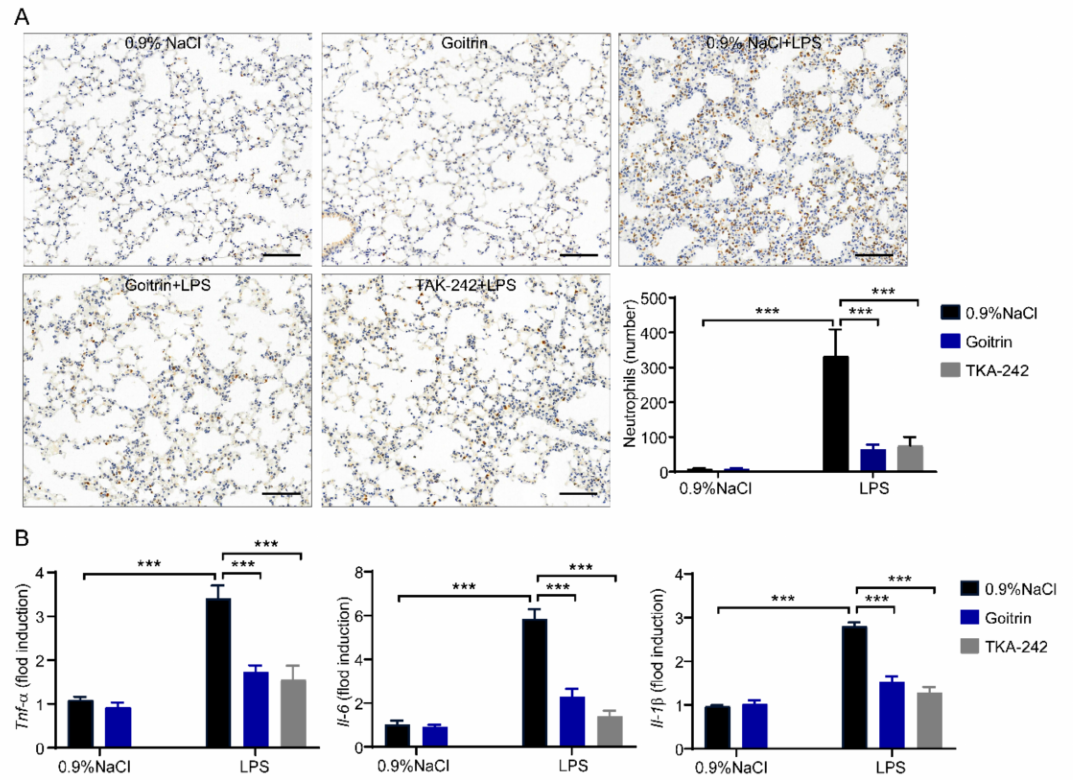
Figure 5. Goitrin attenuated LPS-induced inflammatory responses in lung. Mice were peritoneally injected with 0.9% NaCl, goitrin (30 mg/kg), or TAK-242 (3 mg/kg) 1 h before LPS (20 mg/kg) intravenous injection ( n = 6). The accumulation of neutrophils was quantified by IHC staining ( A ) and mRNAs expression ( B ) were measured in the lung after LPS injection for 8 h. The data are presented as the means ± SD. *** p < 0.001 (ANOVA LSD test). (scale bar = 50 µ